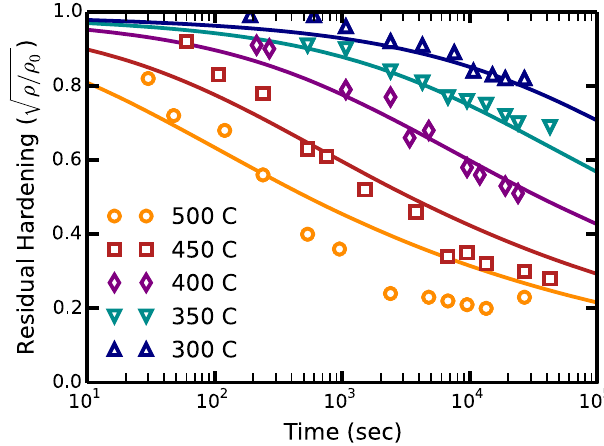
Fig. 9 Experimental data (points) for hardening recovery of cold- worked pure Fe as compared to Eq. (9) when an effective diffusivity accounting for pipe diffusion at lower temperatures is used (lines). Data is shown for each of fi ve